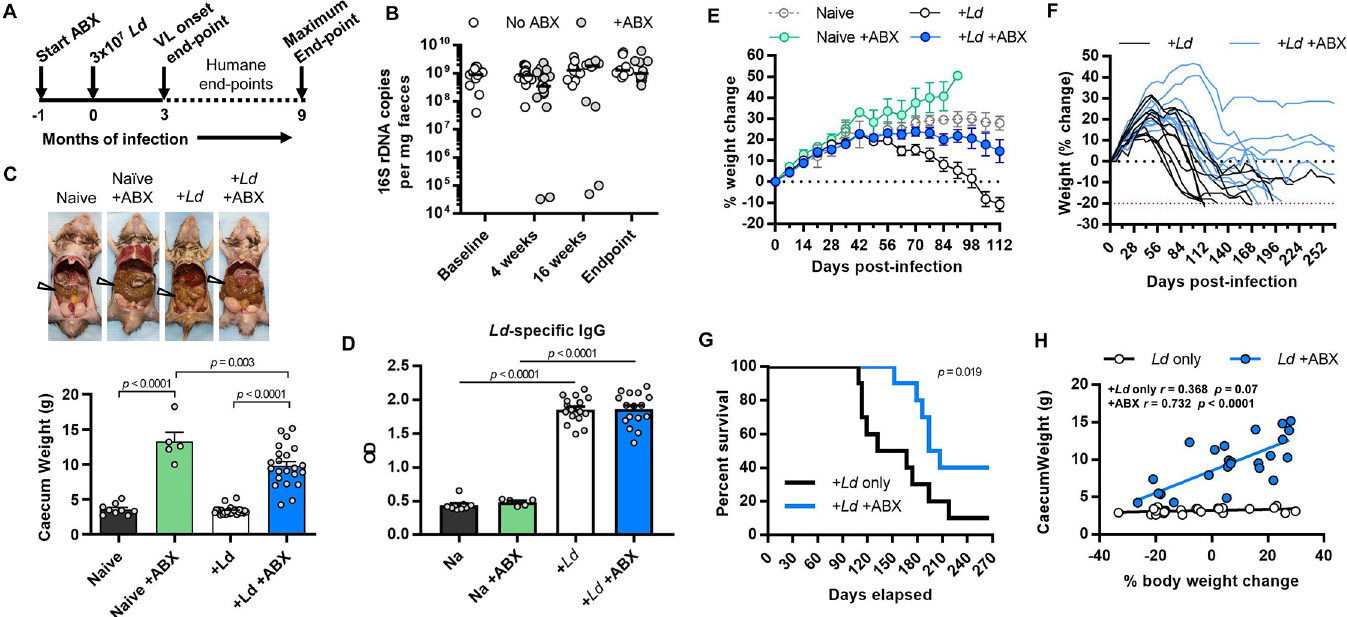
Fig 2. Oral antibiotic treated hamsters have delayed VL disease progression and reduced mortality. (A) Experimental design; (B) qPCR analysis of bacterial 16S rDNA content in hamster faecal pellets at different times (x-axis) before and during oral antibiotic treatment (ABX); Leishmania donovani ( Ld ) infections were initiated at 4 weeks of ABX treatment. Lines show medians. (C) Representative images of viscera at humane end-point and caecum weights at 12 weeks post-infection in Leishmania donovani ( Ld )-infected hamsters maintained on drinking water containing antibiotic cocktail (ABX) compared with na ï ve controls and no ABX controls; arrows indicate caecum. (D) L . donovani whole cell lysate-reactive IgG antibody titres measure by ELISA (OD, optical density), compared by one-way ANOVA. (E,F) Weight change over time, data shown for means (E) and individual animals (F) where dashed red line marks humane end-point. (G) Survival curve for Ld -infected hamsters treated with ABX or not, Gehan-Breslow-Wilcoxon test p = 0.019. (H) Pairwise comparison and Pearson correlation tests of individual animal’s caecum weight and post-infection change in body weight. Experiments using VL onset end point (B, C, D, E, H) n = 5–16 per group; experiments using humane/maximum end-points (F, G), n = 10 per